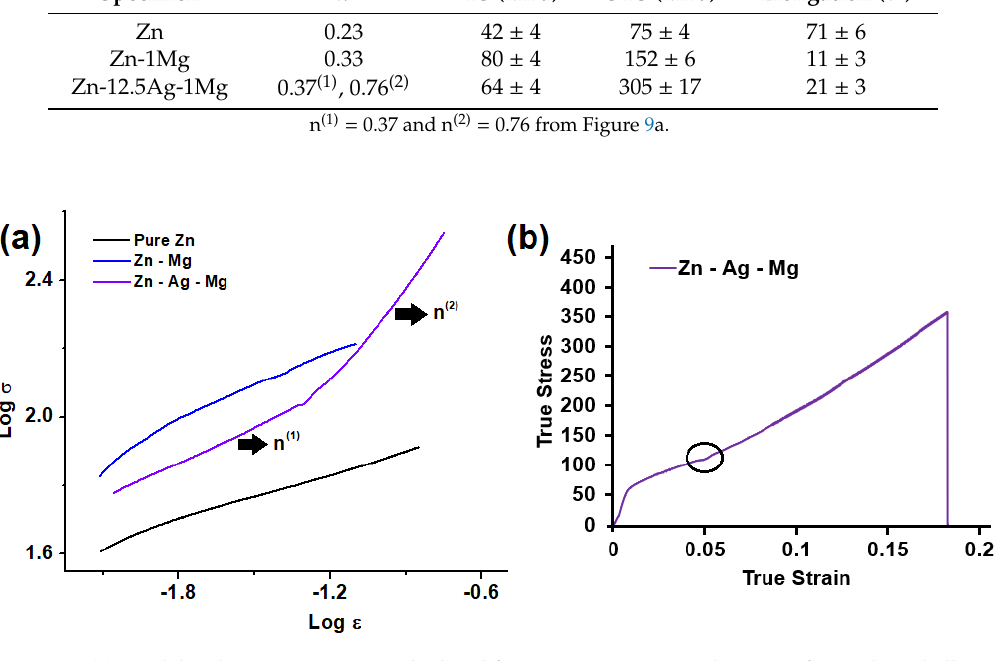
Figure 9. ( a ) Work hardening exponents calculated from engineering tensile curves for Zn-based alloys; ( b ) True stress vs. true strain curve of Zn-based alloys tested at the strain rate of 4.2 × 10 −5 s −1 .